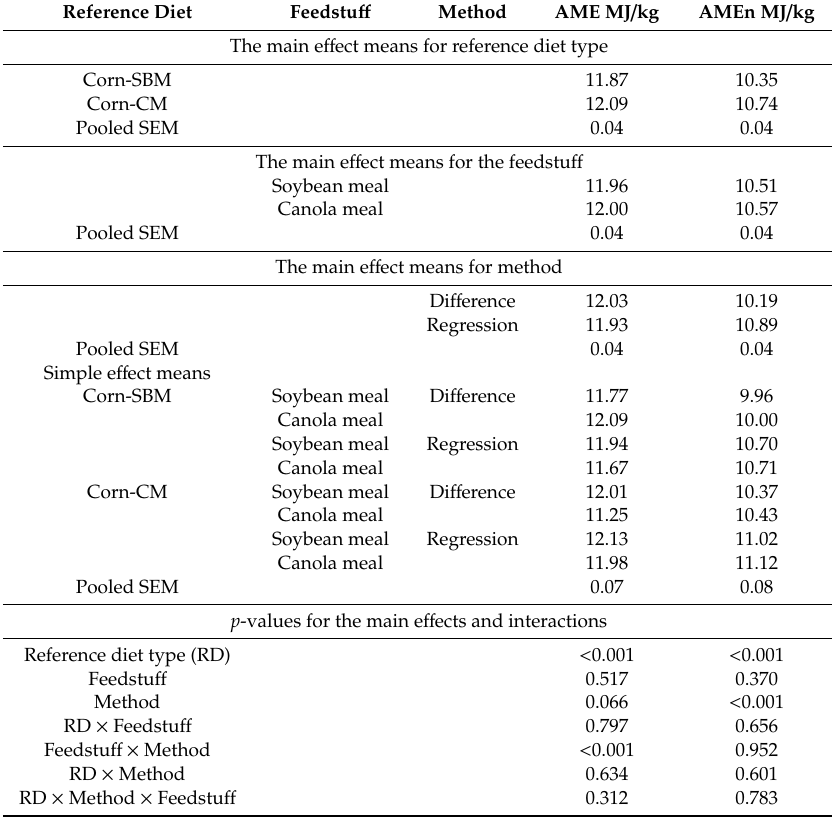
Table 5. Influence of Method on apparent metabolizable energy and nitrogen-corrected metabolizable energy values of soybean meal or canola